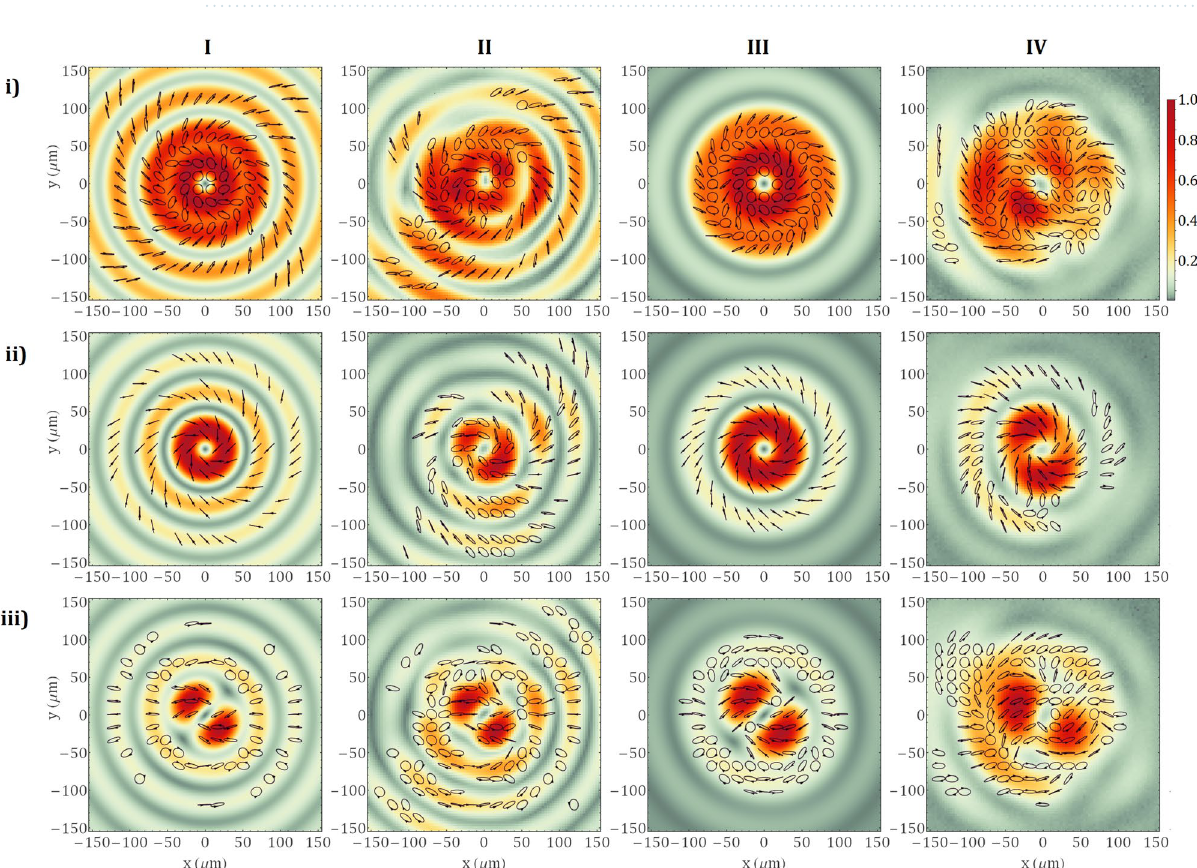
Figure 5. Theoretical modelling from the column I and experimental results from column II were obtained for a Sapphire crystal of 2.72 mm and an input beam generated by the laser oscillator. On the last two columns, III and IV, there are represented the theoretical and experimental results of the high-power laser system. The polarization of the input beam is ( i ) right-handed circular, ( ii ) left-handed circular and ( iii )